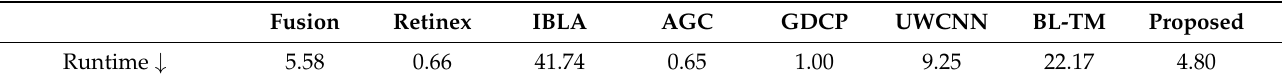
Table 2. Average runtime in seconds on the UIEB dataset [25].